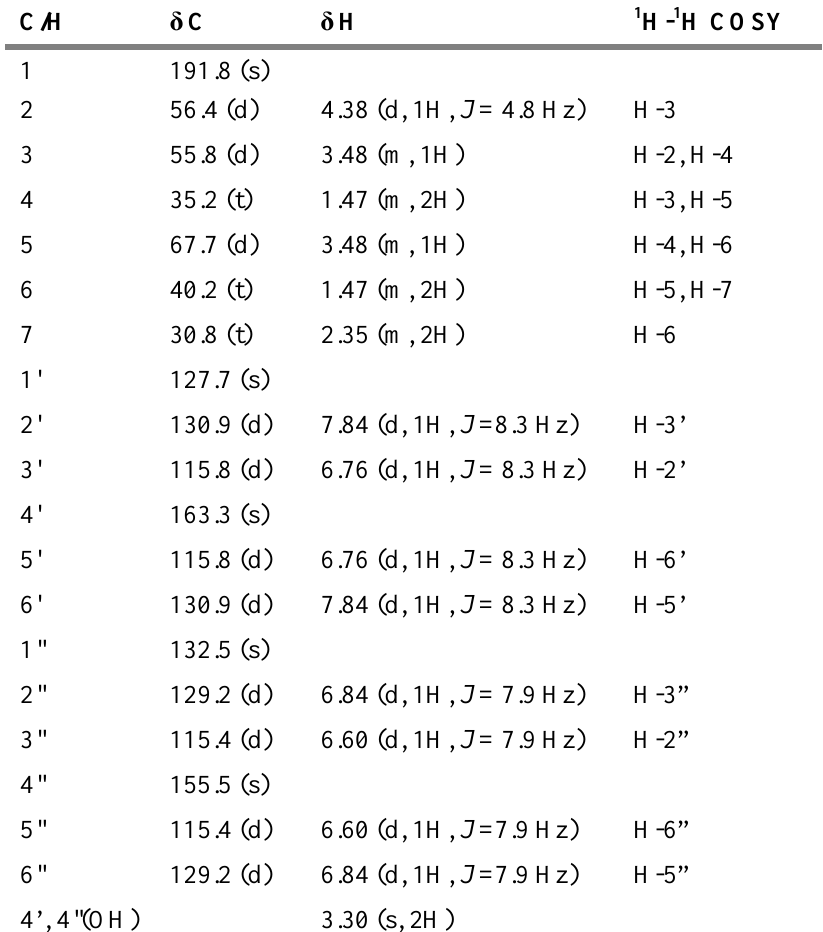
Table 1. 1 H- and 13 C-NMR data of